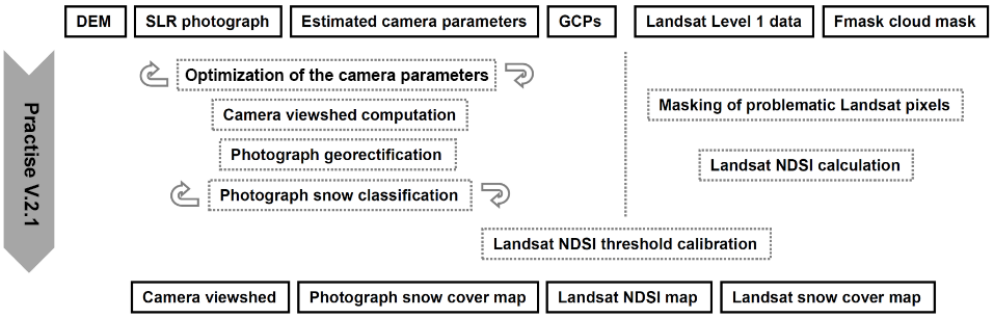
Figure 2. Input and output data and the workflow of PRACTISE (version 2.1) used to generate the calibrated NDSI snow cover maps from Landsat data (from Härer et al., 2016).